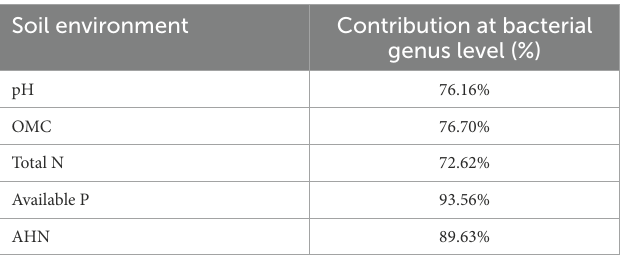
TABLE 4 Contribution of soil environment to bacteria taxa at the genus